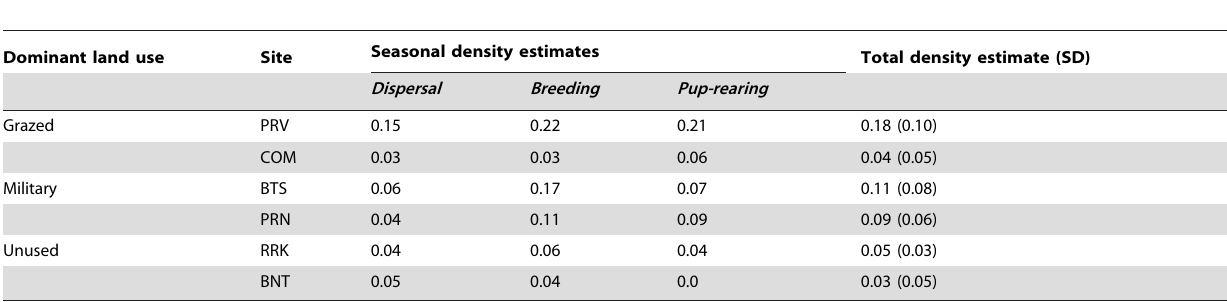
Table 5. Swift fox population density estimates (foxes/km 2 ) on 6 study sites exposed to 3 land use practices in southeastern Colorado, USA, 2001–2004.